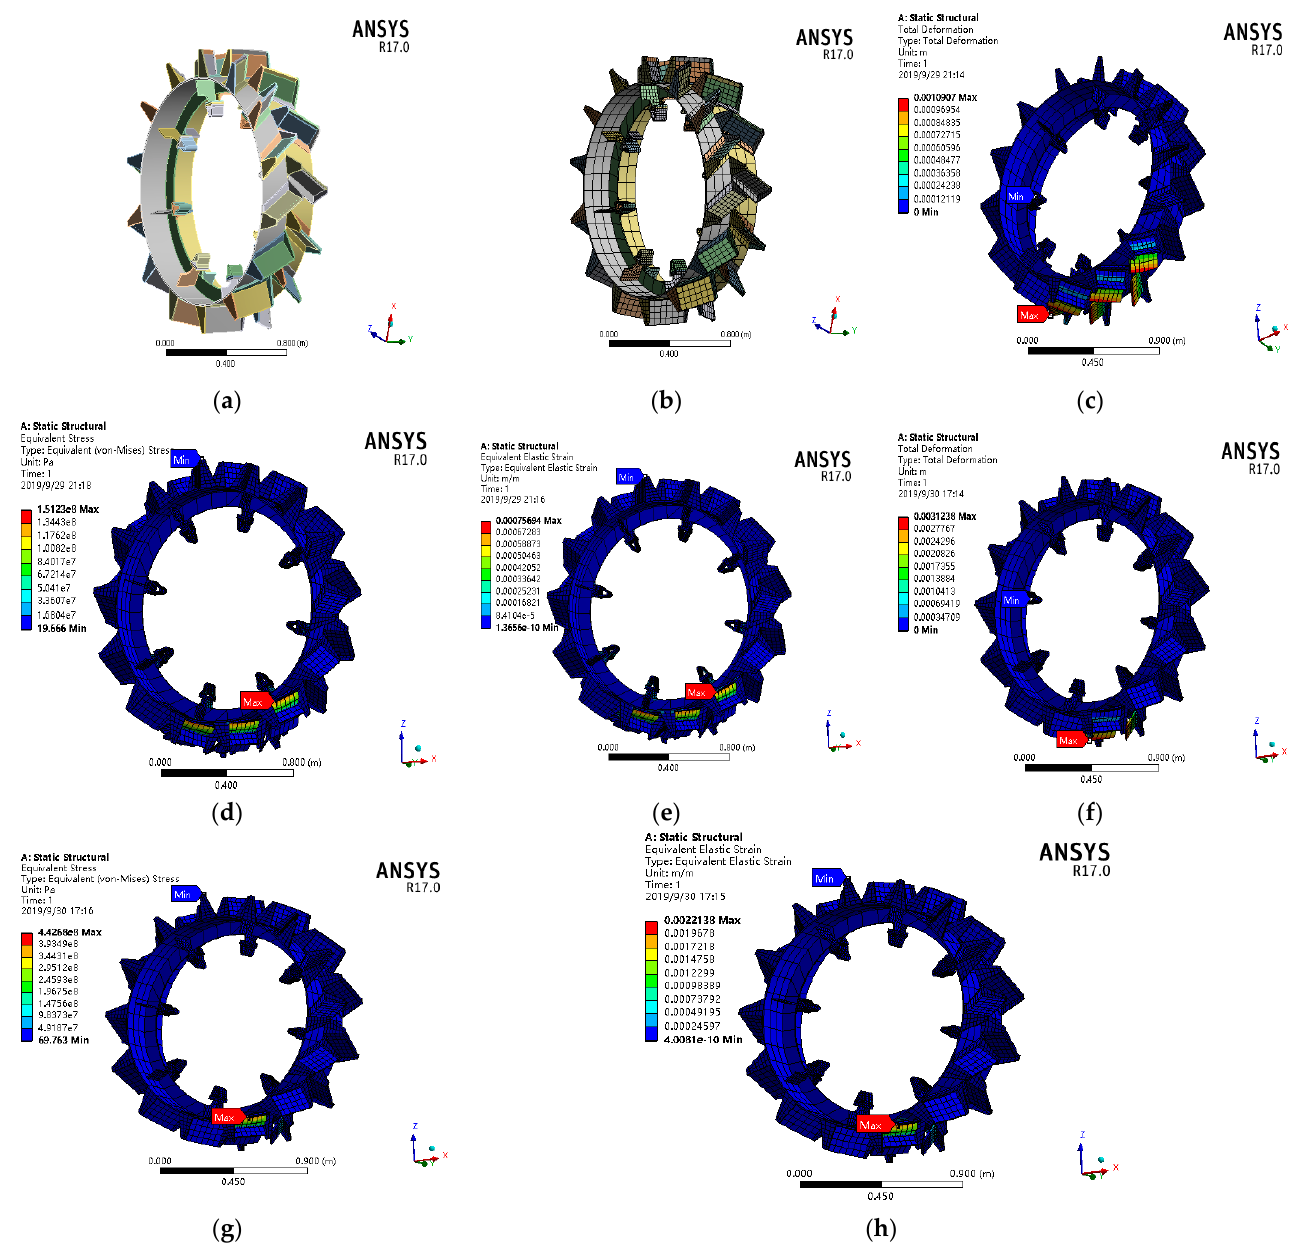
Figure 12. Static structural simulation analysis process in ANSYS under applied loads and results of the analysis in different surface soil conditions.